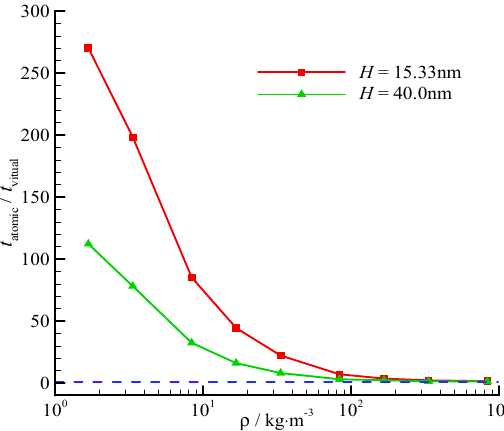
Figure 7. Computational time reduction ratio of the virtual-wall model. The blue dashed line represents for the time reduction ratio is 1.